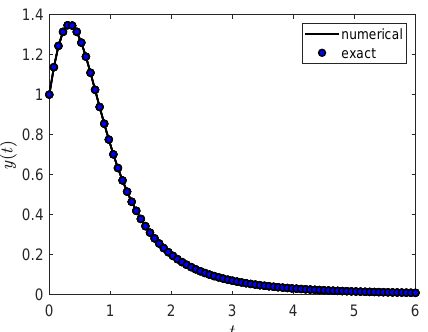
Figure 5. Graphs of the exact and approximate solutions for example 3.